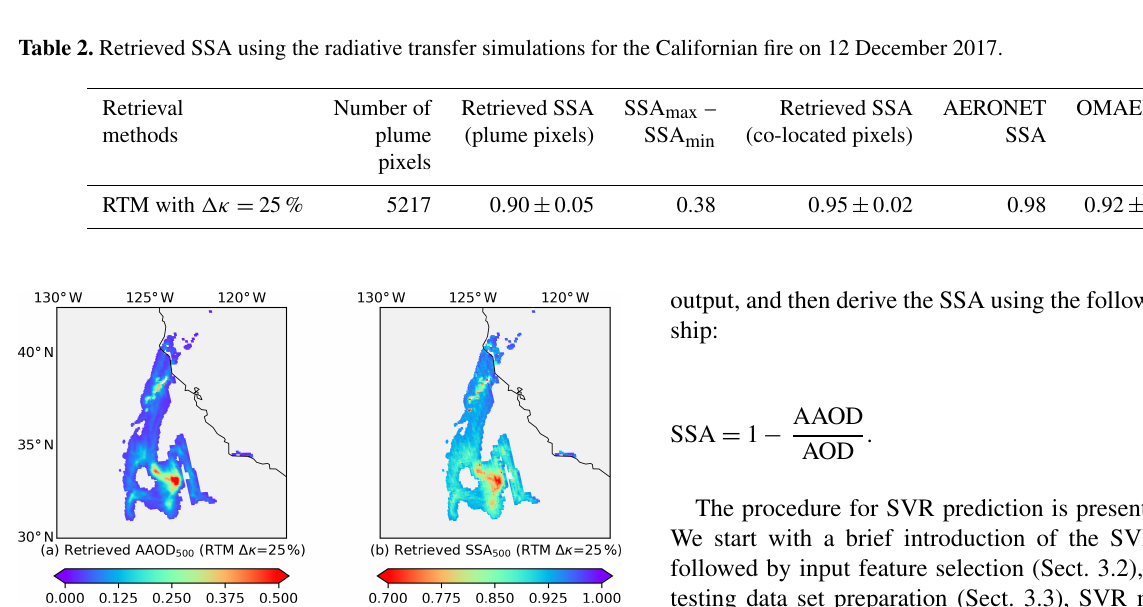
Figure 4. Retrievals of radiative transfer simulations for the Cali- fornian fire event on 12 December 2017 when (cid:49)κ = 25% ( (cid:49)κ = (κ 354 − κ 388 )/κ 388 ): (a) retrieved AAOD at 500nm; (b) retrieved SSA at